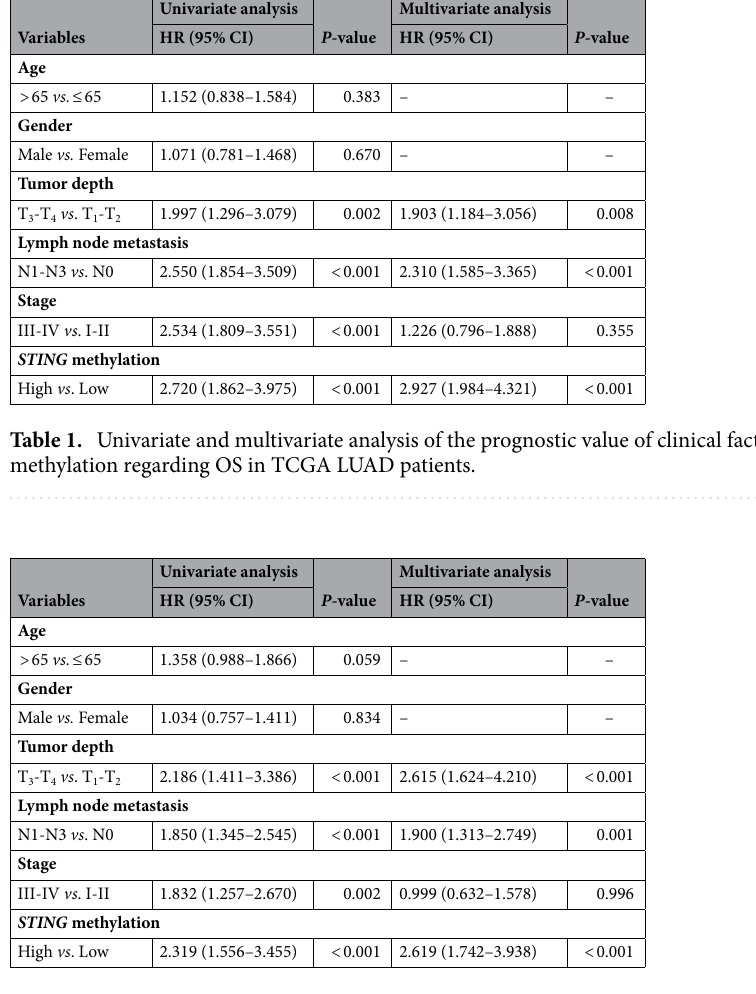
Table 2. Univariate and multivariate analysis of the prognostic value of clinical factors and STING methylation regarding DFS in TCGA LUAD patients.